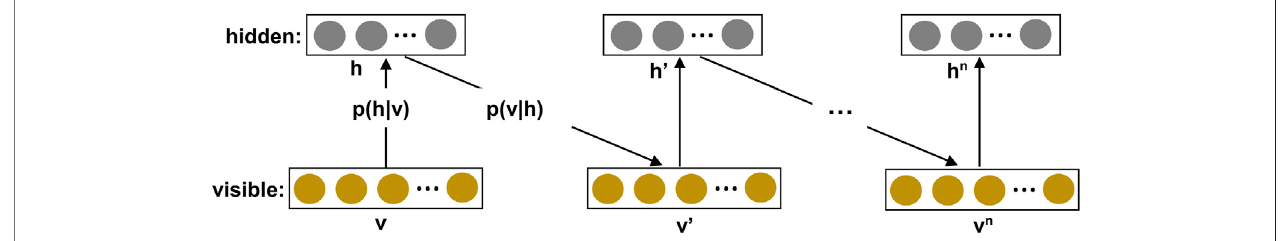
FIGURE3| IllustrationofthecontrastivedivergencealgorithmfortrainingaRestrictedBoltzmannMachine(RBM).Ifsamplingstopsat n th GibbsstepoftheMarkov Chain, the procedure is known as CD-n.